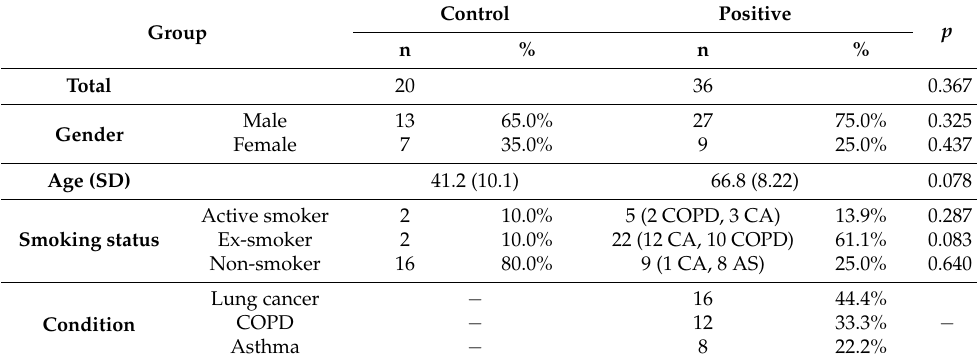
Table 5. Main information regarding volunteers (SD = standard deviation, CA = lung cancer, COPD = chronic obstructive pulmonary disease, AS =